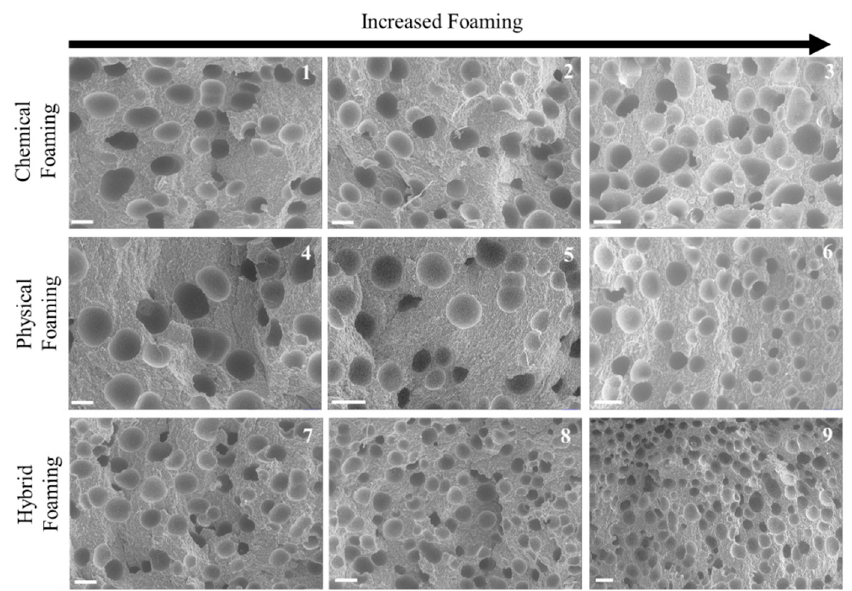
Figure 6. SEM images of talc-filled PP cross sections (white bar indicates 100µm).